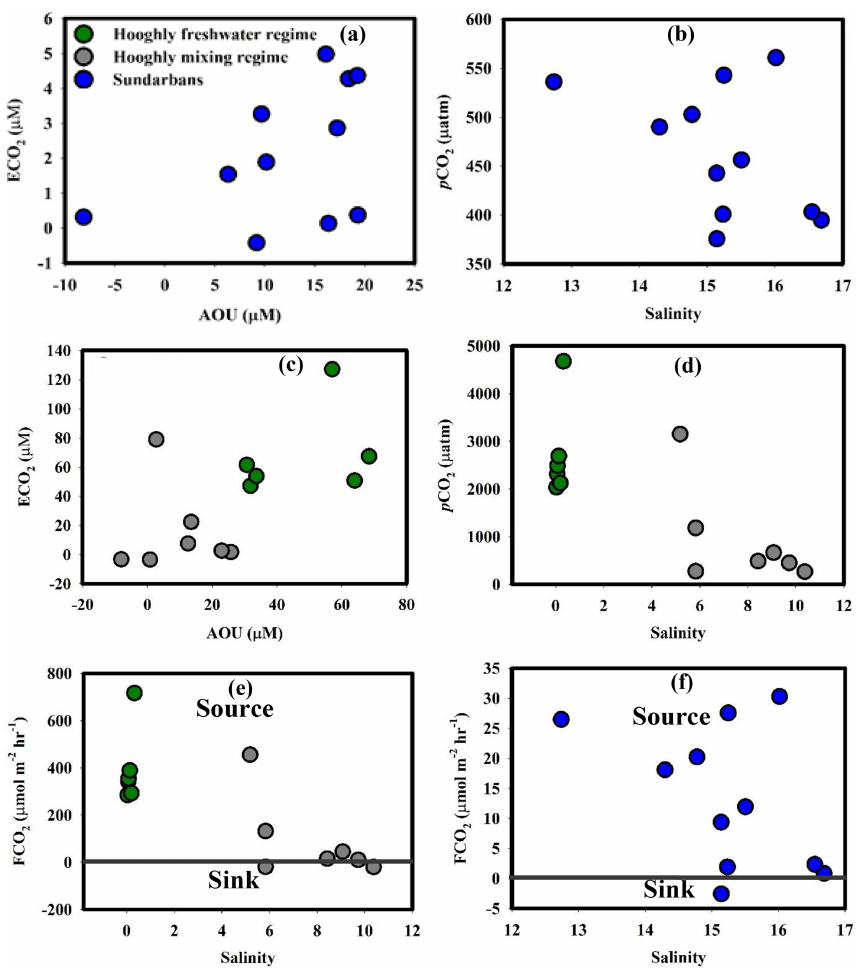
Figure 6. (a) ECO 2 –AOU in the Sundarbans, (b) p CO 2 –salinity in the Sundarbans, (c) ECO 2 –AOU in the Hooghly, (d) p CO 2 –salinity in the Hooghly, (e) F CO 2 –salinity in the Hooghly and (f) F CO 2 –salinity in the Sundarbans.